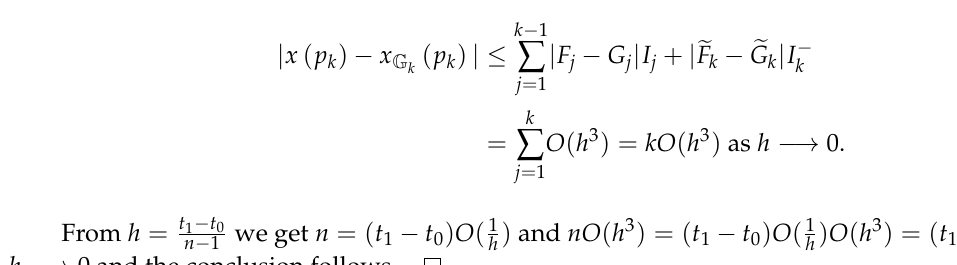
Algorithm ODE-FT : Find an approximated final value x ( P t ∈ [ t 0 , t 1 ] with initial condition x ( t 0 ) = x 0